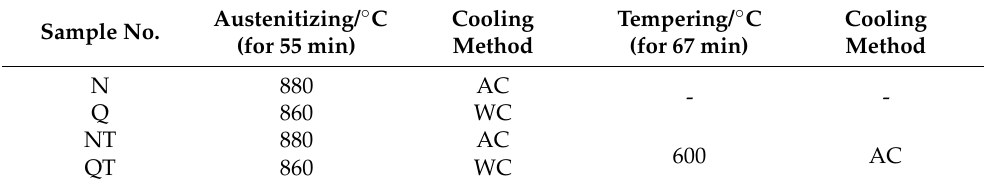
Table 2. The heat treatment protocol of experimental steel. (AC: air cooling, WC: water cooling). Sample